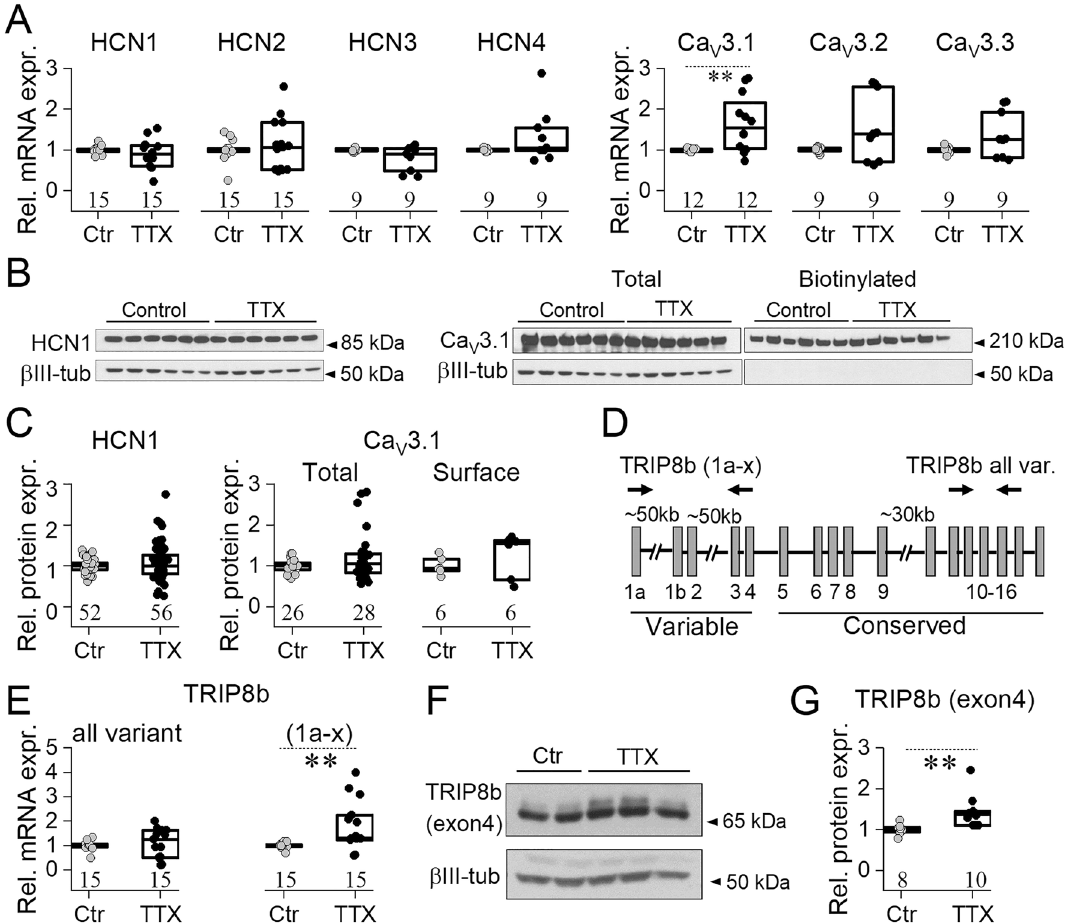
Figure 5. Homeostatic upscaling regulates HCN1 via TRIP8b. ( A ) Analyzing the relative mRNA expression of HCN and Ca V 3 subunits revealed that only Ca V 3.1 mRNA level is increased upon chronic TTX treatment. ( B ) Representative western blots show HCN1 and Ca V 3.1 protein signals in whole cell (total) or in biotinylated cell lysates from control and TTX-treated hippocampal neuronal cultures. ( C ) Quantification of HCN1 and Ca V 3.1 western blot data, displaying normalized HCN1 and total Cav3.1 levels to their corresponding βIII- tubulin levels or precipitated (surface) Cav3.1 levels, normalized to the average of control sample intensities developed within the same blot. ( D ) Schematic illustration of the TRIP8b gene. Arrows indicate localization of the used primers in RT-qPCR. ( E ) Quantification of TRIP8b mRNA expression shows a significant increase in the TRIP8b (1a-x) splice variant. ( F ) Representative western blots from control and TTX-treated culture lysates to detect TRIP8b (exon4) level. ( G ) Deprivation of spontaneous firing activity significantly increased the TRIP8b (exon4) protein level. In case of RT-qPCR, relative expression levels were normalized to GAPDH while βIII-tubulin was used as loading control in western blots. Box plots indicate medians and 25–75% range of data. RT-qPCR data are derived from 4 (HCN1, HCN2, TRIP8b all variant, TRIP8b (1a-x)) and 3 (HCN3, HCN4, Ca V 3.1, Ca V 3.2, Ca V 3.3) independent cultures while protein levels were detected in cell lysates obtained from 19 (HCN1), 11 (total Ca V 3.1), 2 (biotinylated Ca V 3.1) and 4 (TRIP8b (exon4)) independent cultures. Number of recorded cells is indicated on the graphs (**p < 0.01). For statistical analyses, independent samples t-tests (HCN1, HCN2, Ca V 3.1, Ca V 3.2, Ca V 3.3 mRNA levels on ( A )) or Mann–Whitney U tests (HCN2, HCN4 mRNA levels on ( A , C , E , F )) were